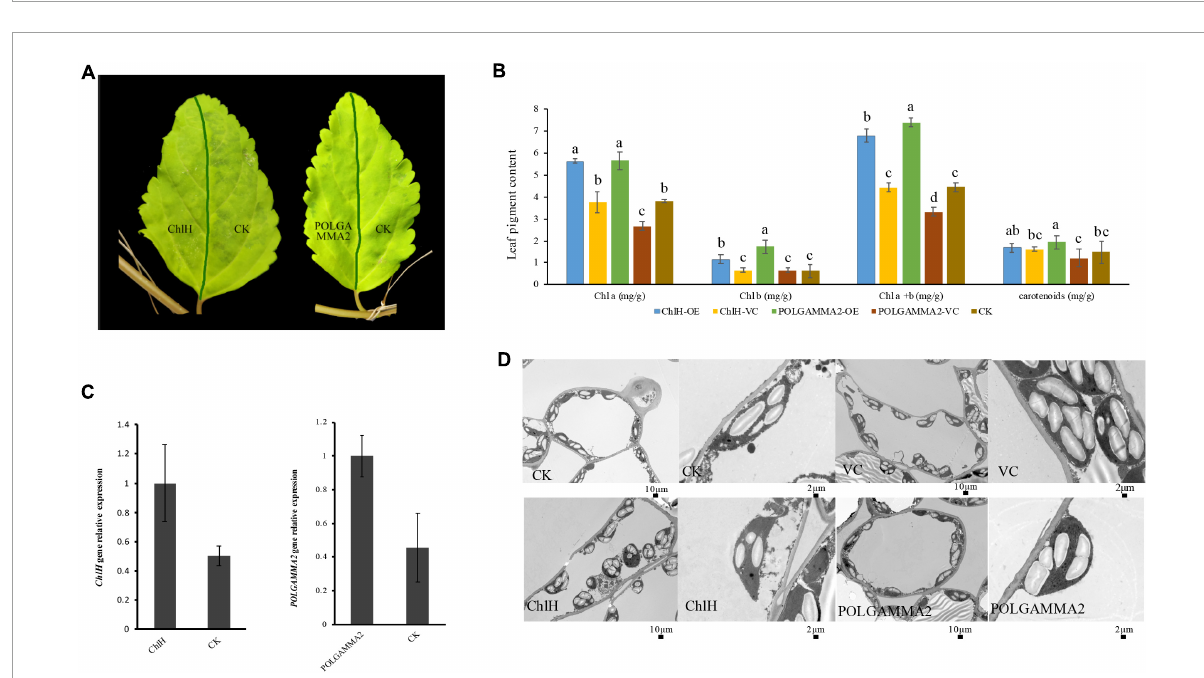
FIGURE5 The leaf color and anatomy change in yellow-leaf Forsythia plants with candidate genes transiently over-expressed. (A) The leaf color of ChlH -OE, POLGAMMA2 -OE, and the non-infected (CK) leaves of Forsythia . (B) The content of Chl a , Chl b , total Chl, and carotenoid in ChlH -OE, POLGAMMA2 -OE, vector control, and the non-infected plants. (C) The relative gene expression of ChlH and POLGAMMA2 in ChlH -OE and POLGAMMA2 -OE plants, respectively. (D) The chloroplast structure of CK, VC (vector control), ChlH -OE, and POLGAMMA2 -OE